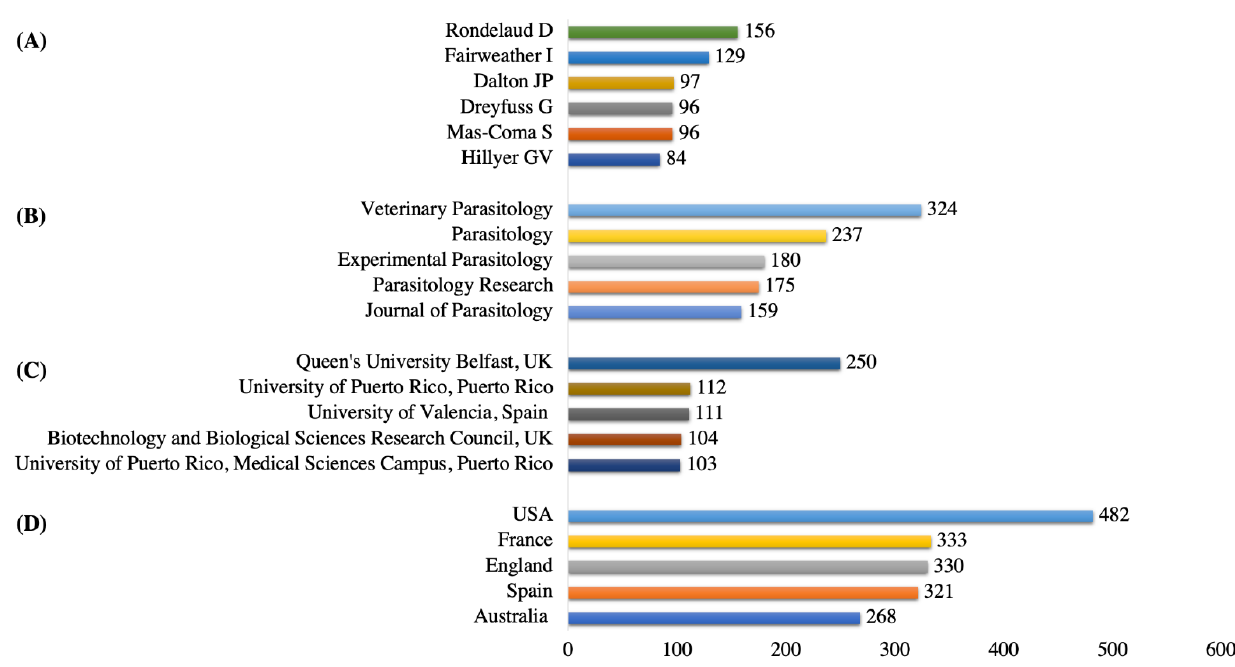
Figure 3. ( A ) Top five authors, ( B ) top five journals, ( C ) top five institutions, ( D ) top five countries in fascioliasis research.